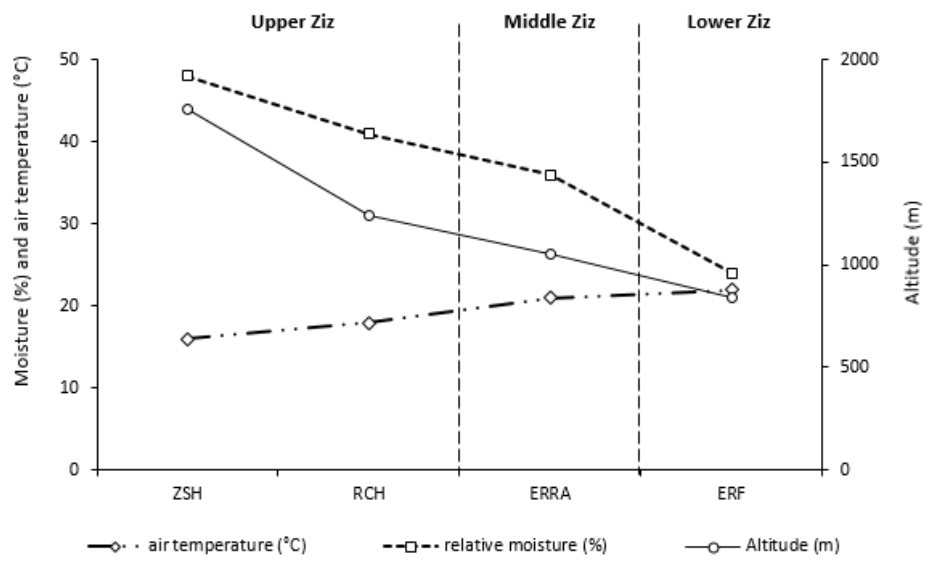
Figure 9. Annual mean values of temperature and humidity as a function of the altitudes of the four sampling stations ((ZSH = Zaouia de Sidi Hamza, RCH = Rich, ERRA = Errachidia, and ERF = Erfoud) (for their localities, see Figure 1).